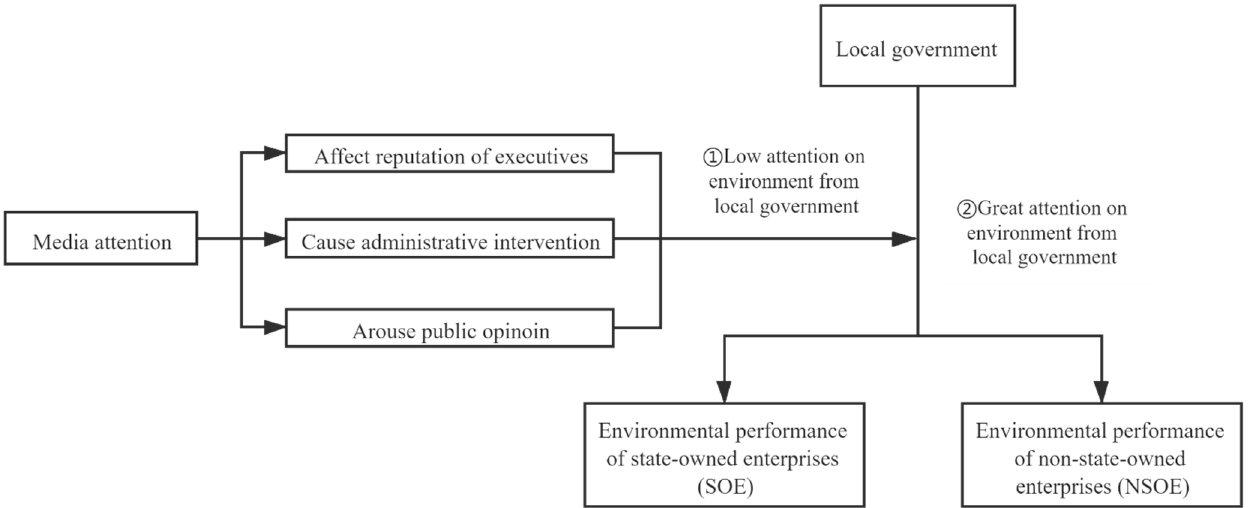
Figure 1. Logic analysis diagram.